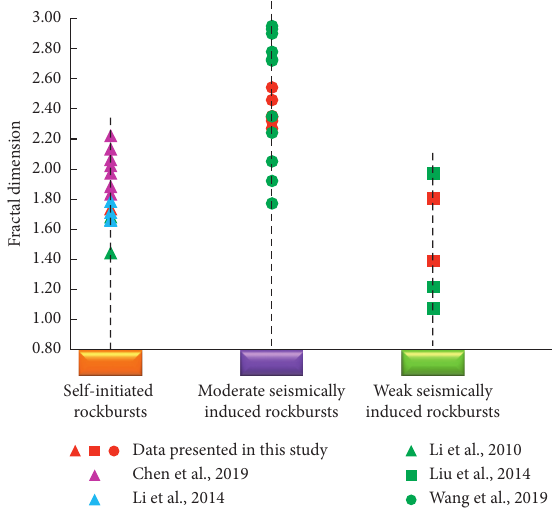
Figure 11: Comparison of the fractal dimensions of different types of